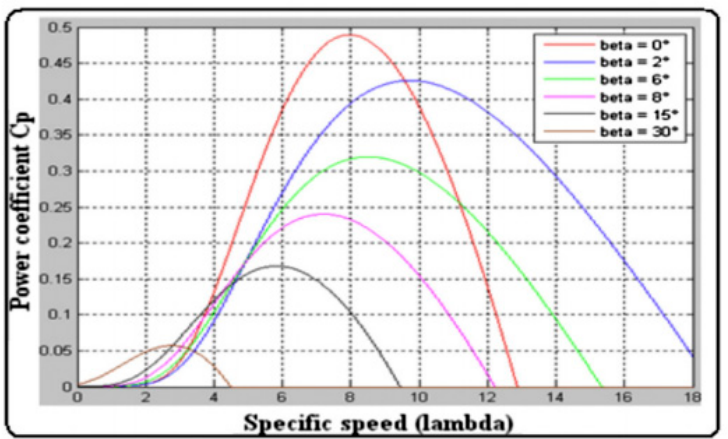
Figure 15. The relationship between the λ , β and Cp .